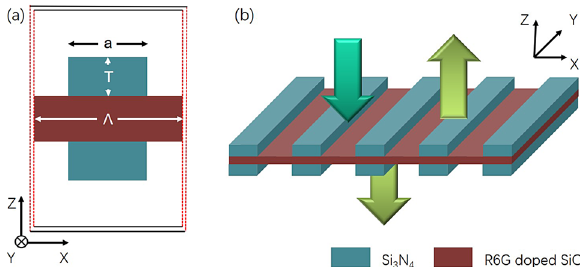
Figure 1: Schematic of proposed resonator based on HCGs: (a) single unit cell of two dimensional resonator; (b) whole structure with the organic R6G thin layer. The dark green downward arrow represents optical pump, the light green arrows on both sides of resonator are emitted light from the resonator.